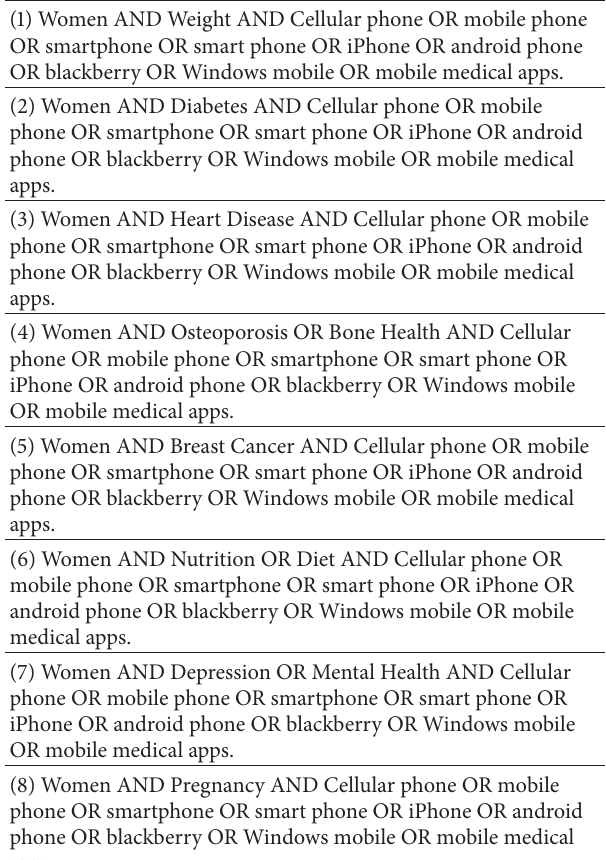
Table 1: Medline and Web of Knowledge search